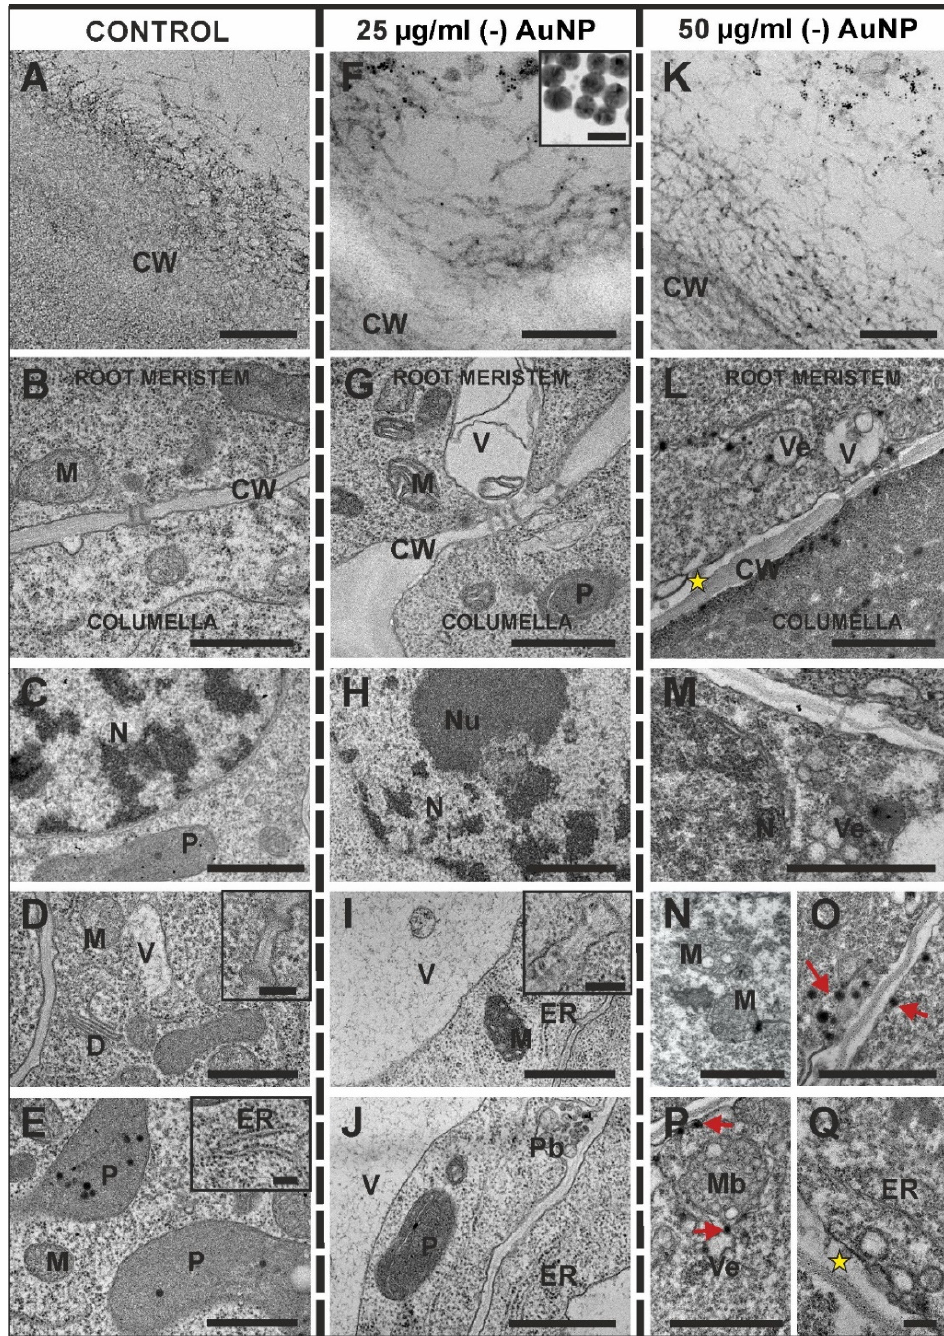
Figure 4. Ultrastructure of the root cap outer cell wall of the control ( A ), those that were treated with 25 μ g/mL ( ‐ ) AuNP ( F ) or 50 μ g/mL ( ‐ ) AuNP ( K ) roots. The outer cell wall had a fibrous character and was a barrier to the entry of ( ‐ ) AuNP into the root cells regardless of the concentration ( F , K ). The ultrastructure of the columella root cap cells from control ( A – E ), the barley roots that were treated with 25 μ g/mL ( ‐ ) AuNP ( F – J ) or 50 μ g/mL ( ‐ ) AuNP ( K – Q ). Red arrows indicate electron‐dense spots inside the cytoplasm; yellow asterisks indicate the periplasmic space; CW—cell wall; ER—endoplasmic reticulum; M—mitochondrion; Mb—multivesicular body; N—nucleus; NU—nucleolus; P—plastid; Pb—paramural body; V—vacuole; Ve—vesicles. Scale bars: ( A , F , K , Q ; D , E , I Insets ) = 200 nm; ( F Inset ) = 10 nm; ( B – E , G – J , L – P ) = 1 μ m.